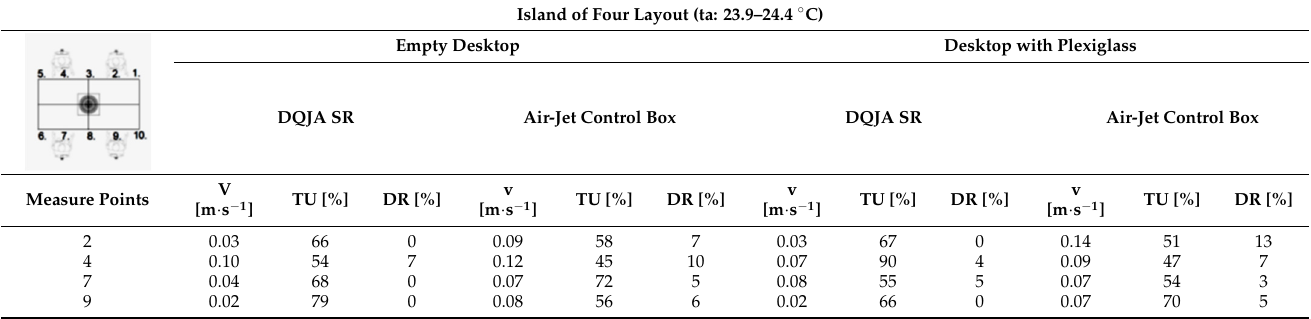
Table 3. Airflow status indicators at the Island of four setup.